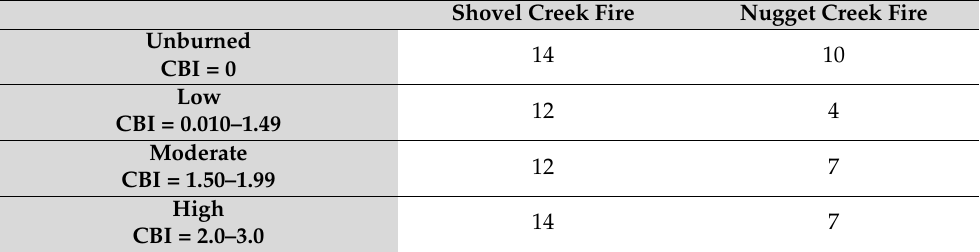
Table 1. Number of plots surveyed by CBI severity class for the Shovel Creek and Nugget Creek fires.